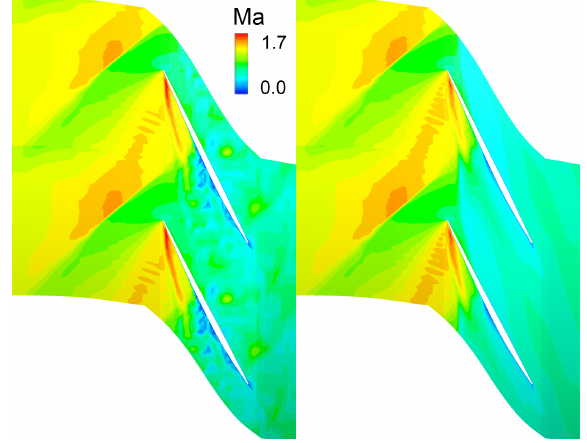
Figure 7. Comparison of relative flow angle distribution. NC: near choke point; PE: peak efficiency point; NS: near stall point.